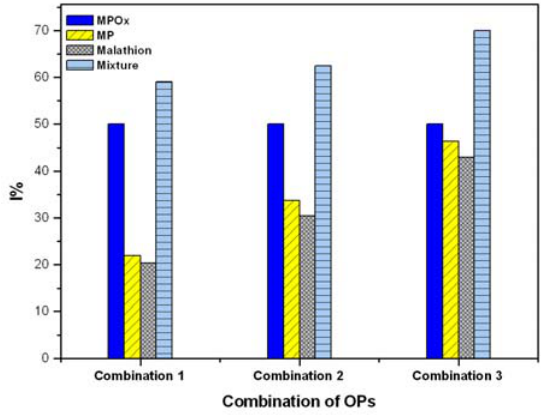
Figure 5. Inhibition pattern obtained for tertiary pesticide mixtures using stabilized BuChE. Mixture combination 1 : MPOx, MP and MT (1 µg·L − 1 each) (1 µg·L − 1 ) and MP, MT (10 µg·L − 1 each), combination 3 : MPOx (1 µg·L − 1 ) MP and MT (100 µg·L − 1 each).